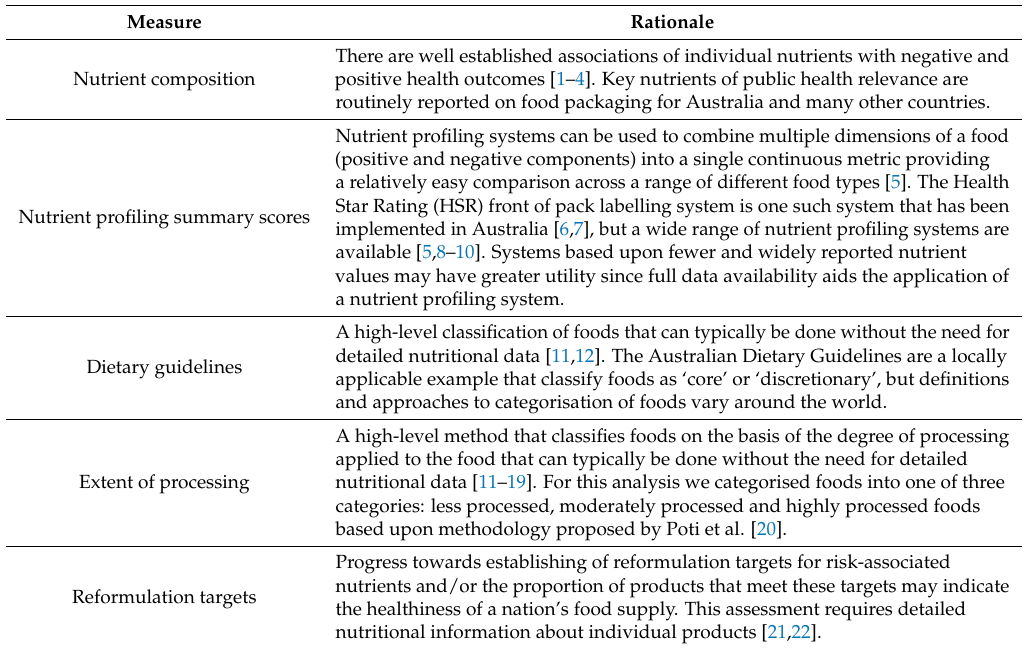
Table 1. Measures and associated rationale used to assess the healthiness of the Australian packaged food